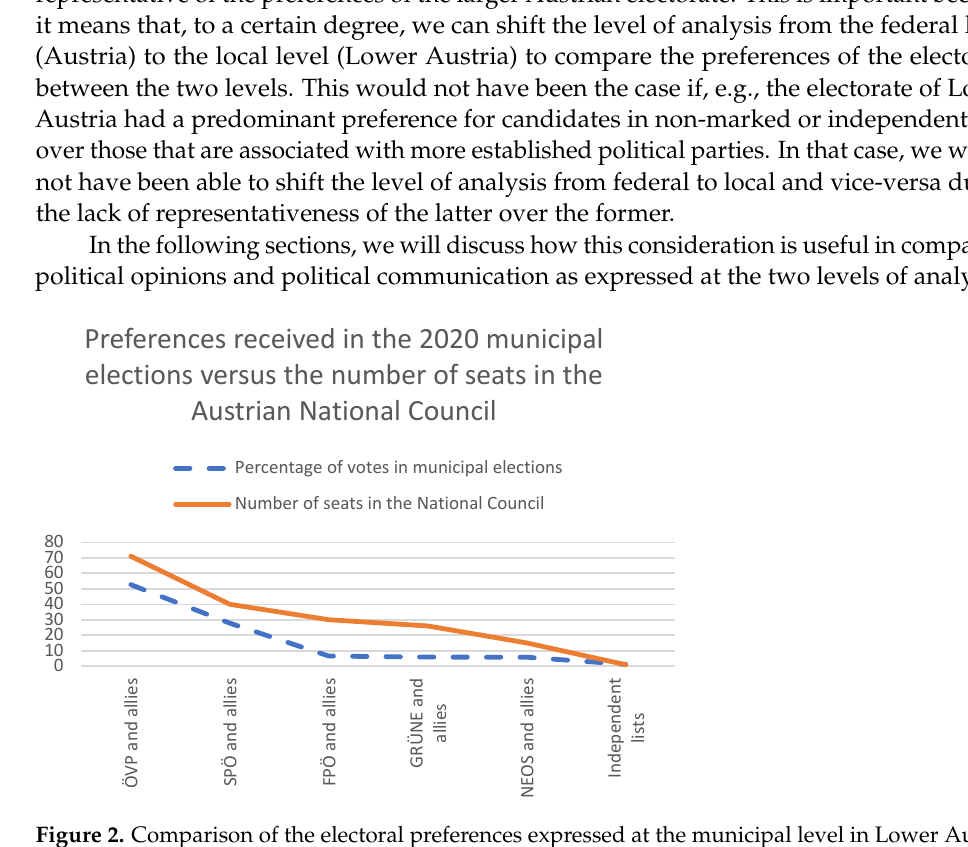
Figure 2. Comparison of the electoral preferences expressed at the municipal level in Lower Austria versus the seats in the National Council of Austria at the federal level.